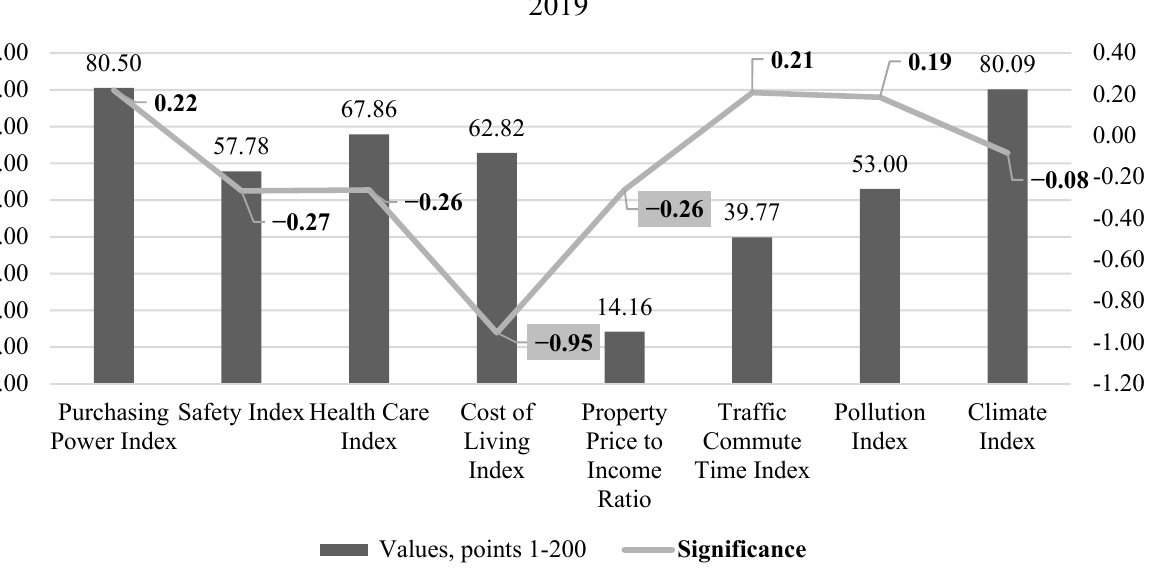
Figure 2. Arithmetic means of the indicators of quality of life and their regressive connection with smart cities in 2019. Source: calculated and built by the authors.